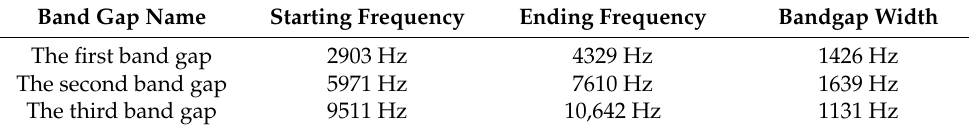
Figure 4. Dispersion curves of the photonic crystal. Table 2. Range of complete band gaps of the phononic